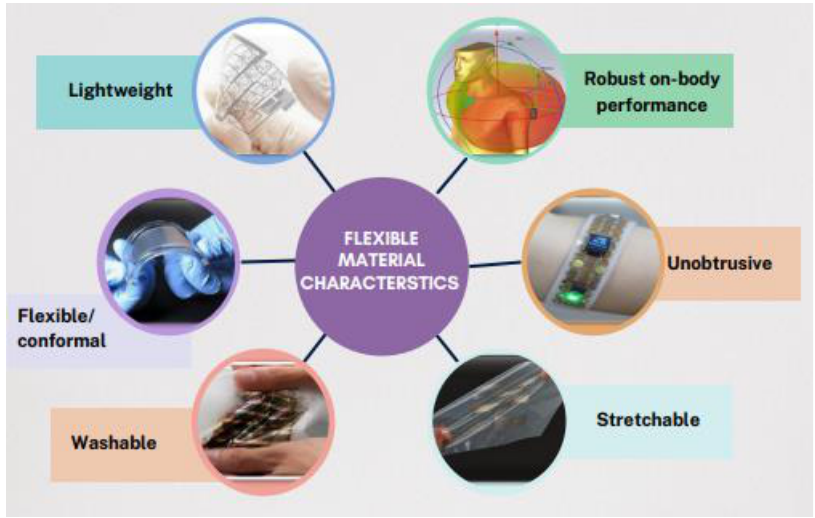
Figure 6. Flexible material